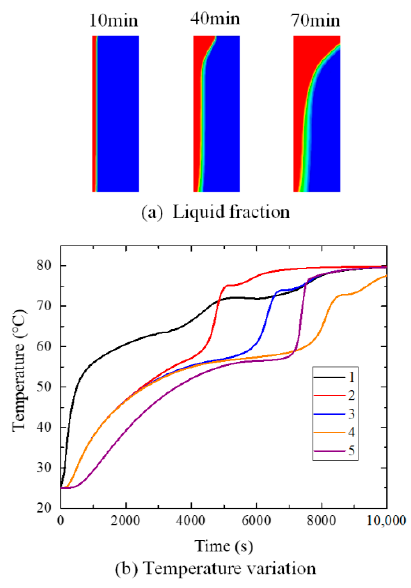
Figure 12. The melting process of paraffin at 90°. ( a ) Liquid fraction; ( b ) temperature variation.